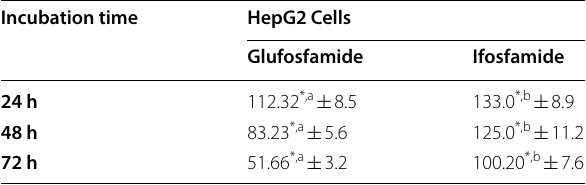
Data represent mean SE, n 6 (Each concentration was processed in triplicate; ± = each experiment was done twice) IC50 values were in µM Each drug was added to culture medium at concentration range; 10–1000 µM HepG2 cells were seeded at 5000–10,000 cells per well Cytotoxicity was assessed using MTT assay * Data in rows having the same superscript are significantly different from each other at P < 0.05 using independent two-tailed Student’s t test a, b Data in columns having the same superscript are significantly different from each other at P < 0.05 using one way analysis of variance (ANOVA) followed